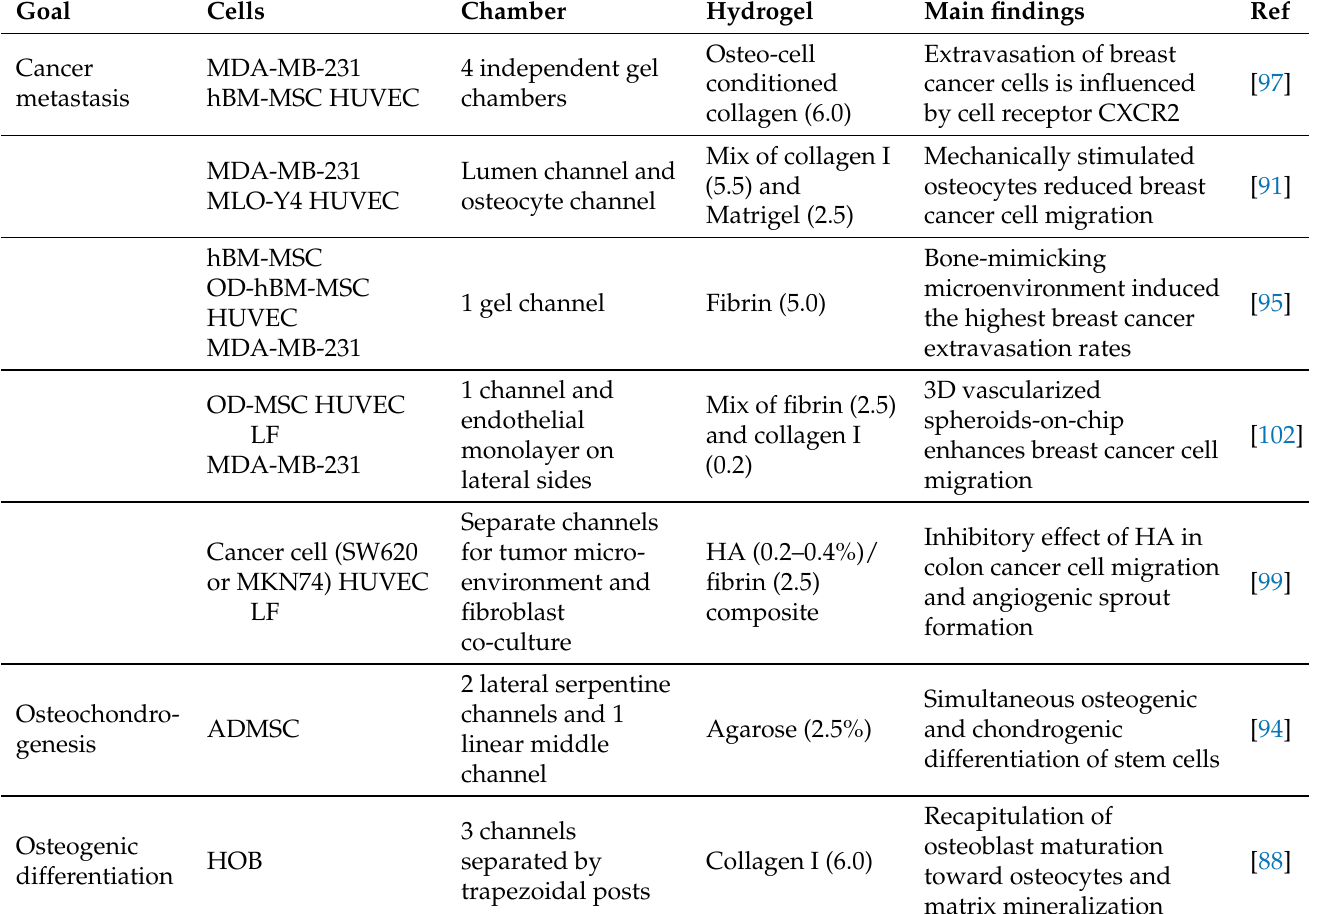
Table 1. Selection of recent studies using hydrogel-based bone-on-chips to model physiological or pathological bone microenvironments. Hydrogel concentrations are between brackets and expressed in mg/mL or weight/volume%. Abbrevi- ations: hBM human bone marrow derived, MSC mesenchymal stem cell, MDA-MB-231 human mammary adenocarcinoma cell (high invasion capacity), HUVEC human umbilical vein endothelial cell, MLO-Y4 murine osteocyte-like cell Line, OD osteoblast-differentiated, BMSC bone marrow stromal cell, SUP-B15 acute lymphoblastic leukemia cell line, HOB primary human osteoblasts, HS5 human bone marrow stromal cell line, DBP bone-inducing demineralized bone powder, BMP bone morphogenetic protein, HA hydroxyapatite, SW620 human colon cancer, MKN74 human gastric cancer, LF human lung fibroblast, ADMSC adipose-derived mesenchymal stem cell, ECM extracellular